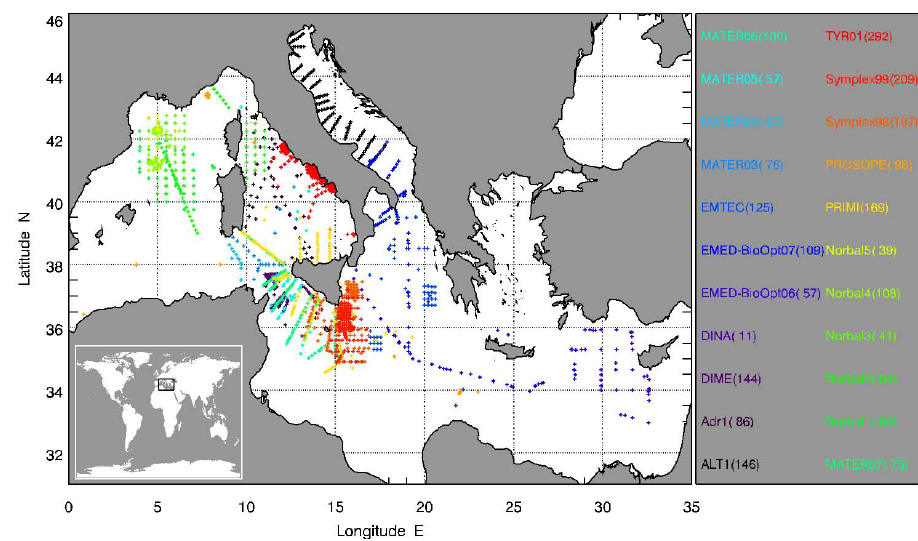
Fig. 2. Location of the in situ CHL dataset. Every cruise is identified by its own colour. For more details about each cruise see Table